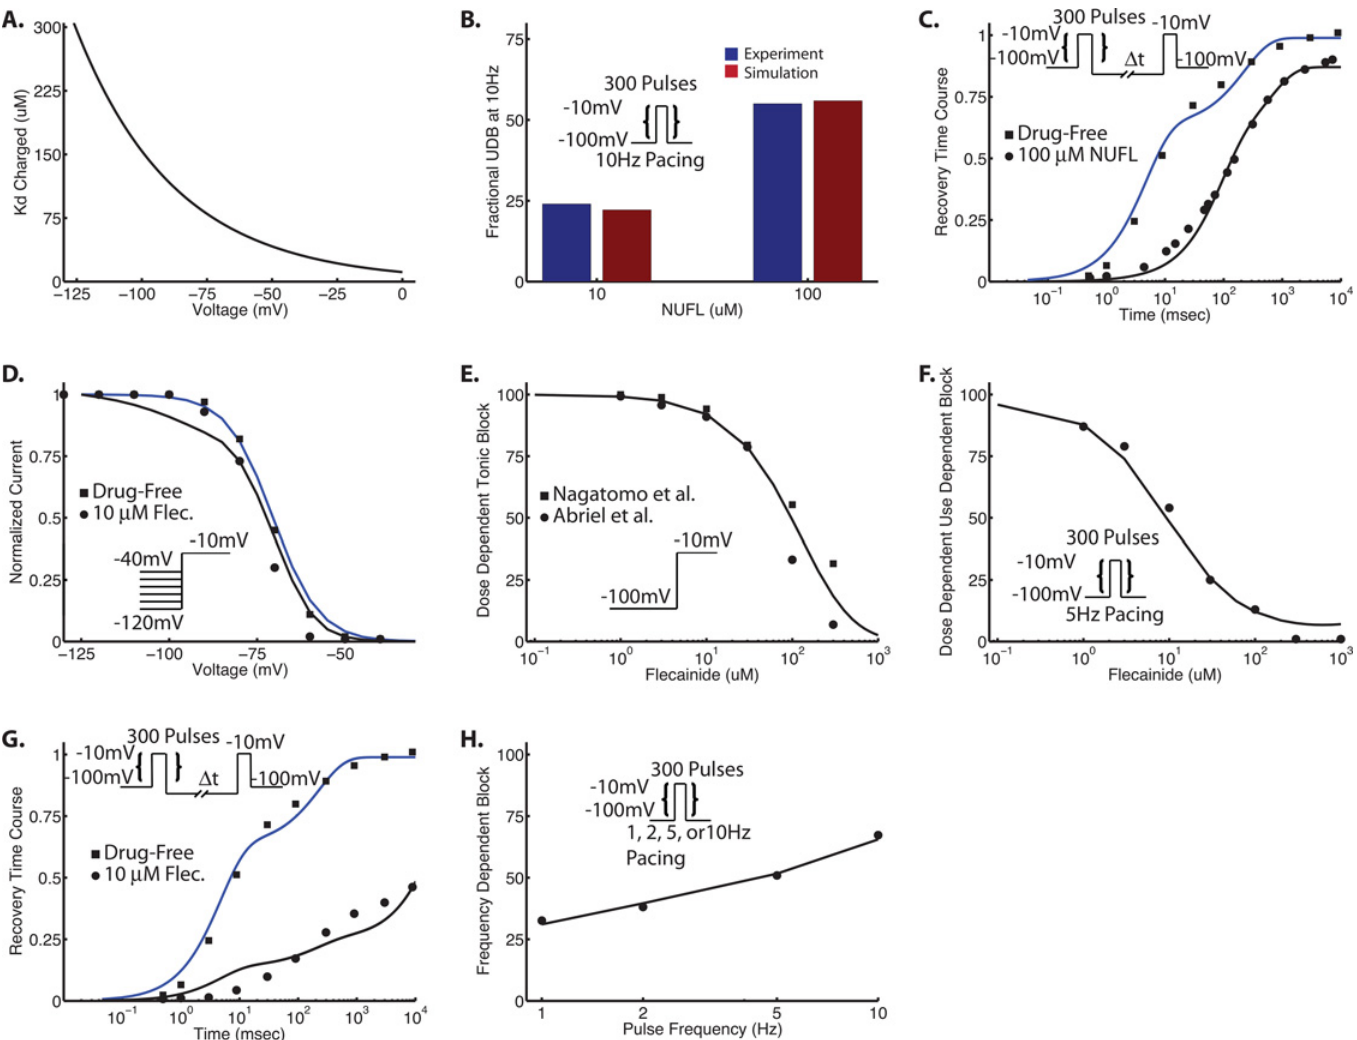
Fig 6. Flecainide drug binding. In panel (A,) a computed Kd curve is generated from Kd = Kd 0 * e (-d * V * F/(R * T)) with Kd 0 = 11.2 (Kd at 0 mV). Kd -100mV = 175.8 μ M. See Table 3 . Panel B and C are the results from optimization of neutral rate constants for flecainide using a neutral flecainide derivative (NUFL). Panel (B) is use-dependent block at 10 Hz for 10 μ M and 100 μ M flecainide. Blue bars are experiment [10], and red bars are the result of the simulation. Panel C is recovery from UDB with 100 μ M NUFL. Panels (D – H) are the results of the optimization for charged flecainide under a variety of protocols: (D) – steady state availability, (E) – tonic block (1-pulse block), (F) – use-dependent block (UDB), (G) – recovery from UDB, and (H) – frequency dependent use- dependent block. Protocols are shown as